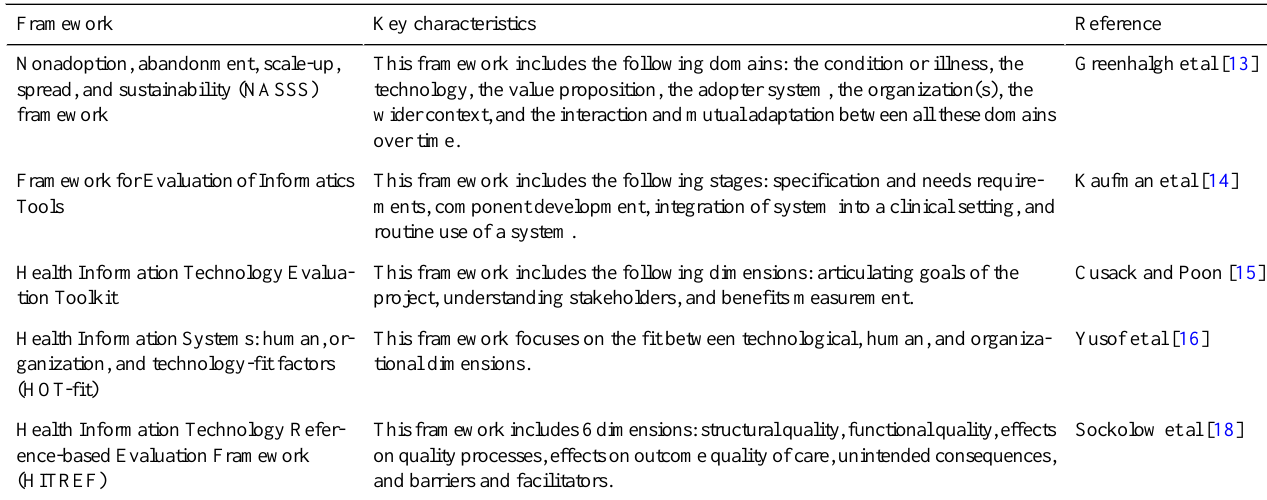
Table 1. Examples of existing health information technology evaluation